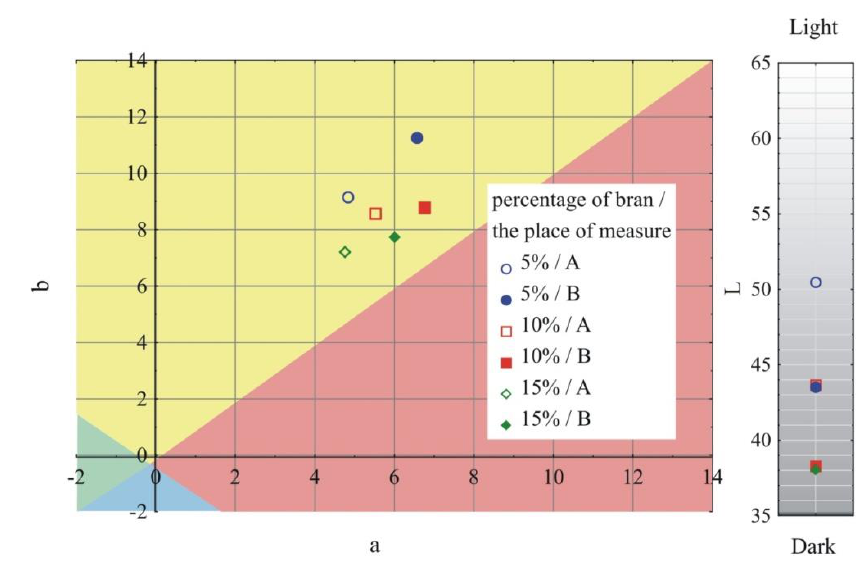
Figure 3 . Variability of the color parameters L, a, b of injection mouldings depending on the content of the mass fraction of bran and grain size 0.4 – 0.6 mm at measuring points A and B (position of measuring points marked in Figure 1).